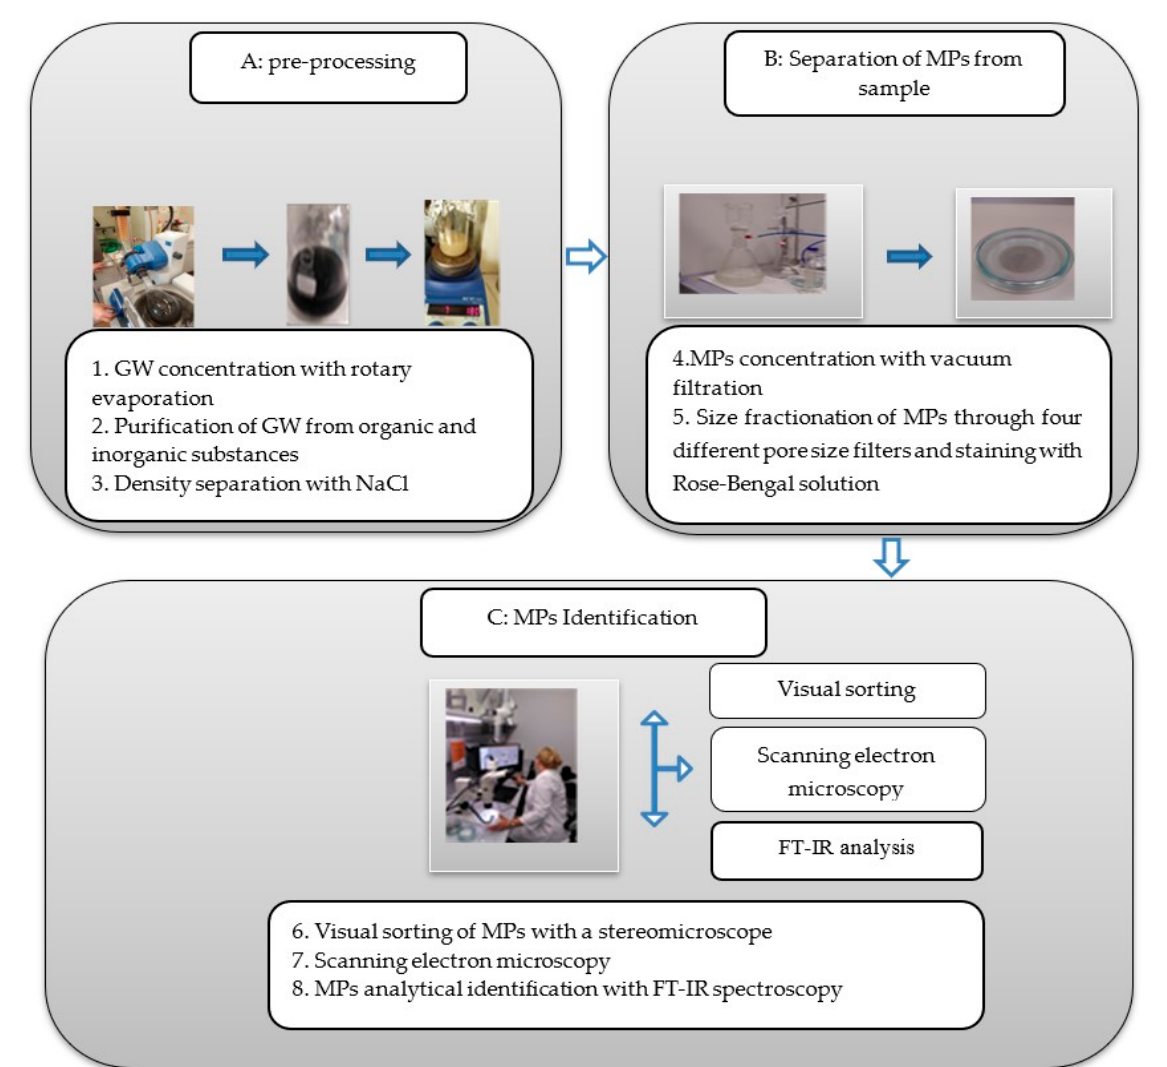
Figure 2. The visual representation of analysis procedures.